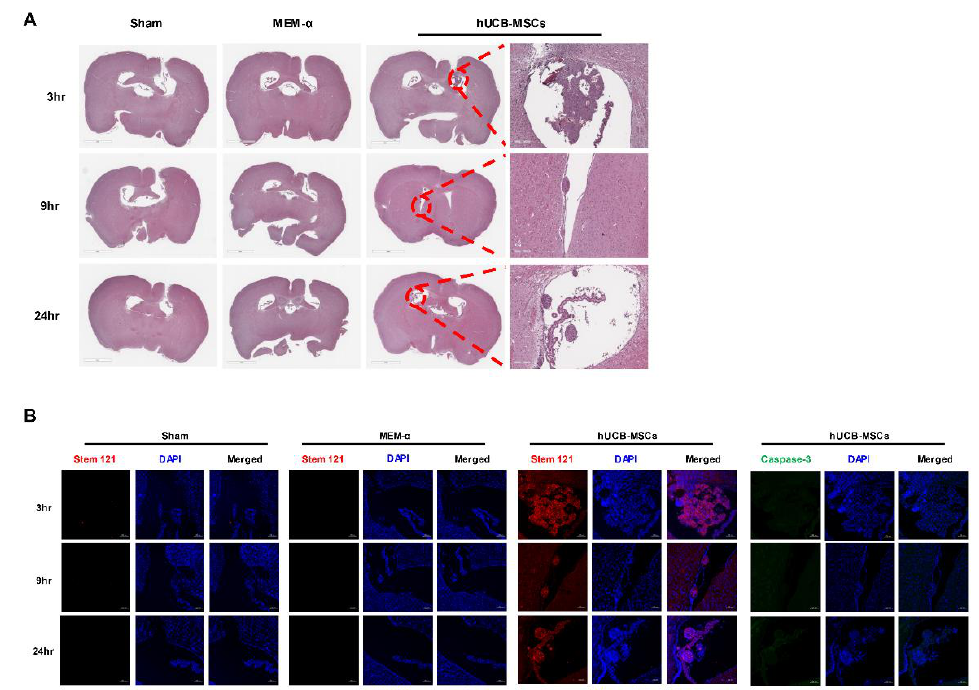
Figure 3. Adherence of hUCB-MSCs to the ependyma cell wall of the mouse brain. ( A ) Transplantation of hUCB-MSCs into the lateral ventricle of 5xFAD mouse is shown via H&E staining. hUCB-MSCs were observed only from the hUCB-MSC groups sacrificed at the 3, 9, and 24 h post transplantation. Adherence of hUCB-MSC aggregates to the ependymal cell layer was observed. ( B ) The cell aggregate was identified as the transplanted human MSCs using the human-cell-specific marker, STEM 121 (red signal) and cell death marker, caspase-3 (cleaved caspase-3, green signal). H&E: Scale bar = 2 mm ( left ), 200 μm ( right ), IHC: scale bar = 100 μm.